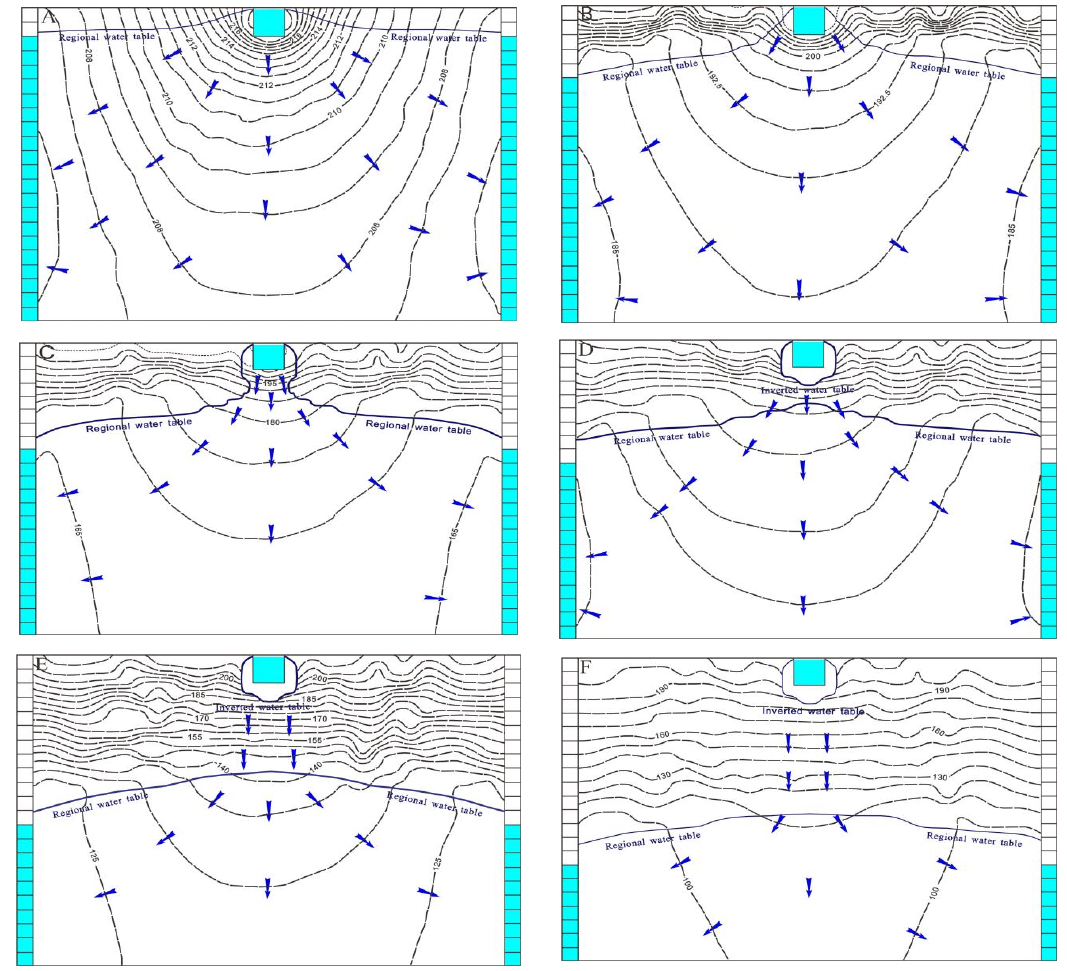
Figure 3. The change in the relationship between river water and groundwater in the sandbox experiment under the water bearing medium sand C and a river water depth of 18.5 cm. Discharge water level ( A ): 200 cm, ( B ): 170 cm, ( C ): 140 cm, ( D ): 130 cm, ( E ): 100 cm, and ( F ): 70 cm.